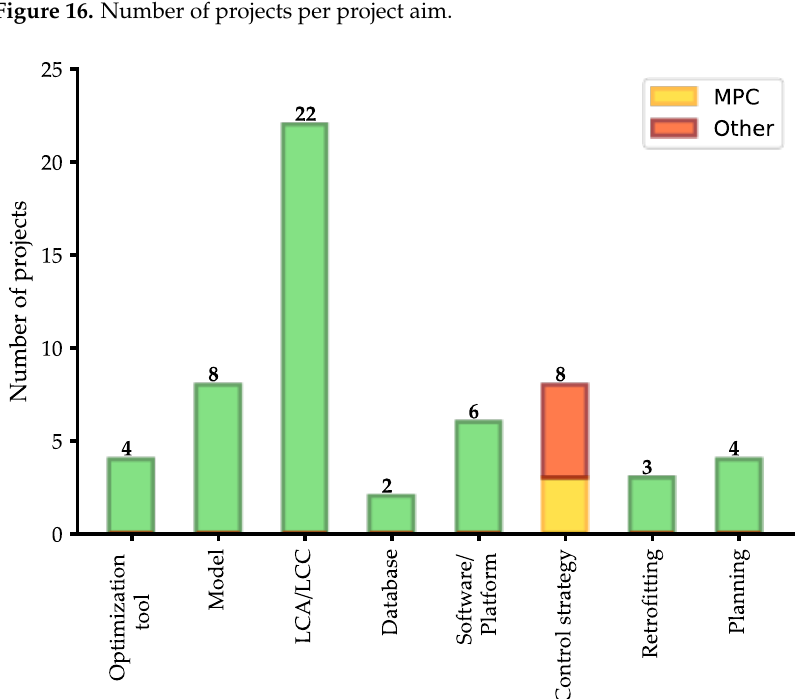
Figure 16. Number of projects per project aim.